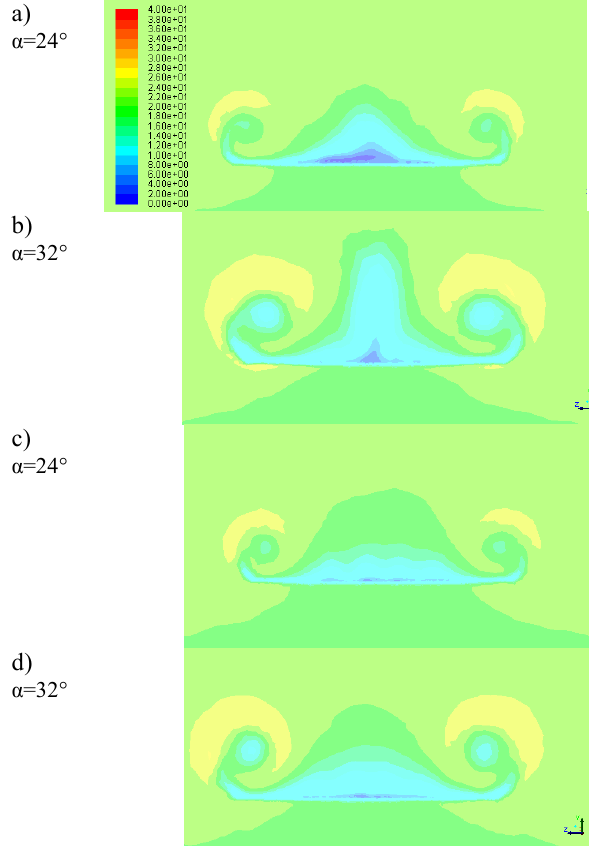
Fig. 6. The velocity contours at cross plane of the wings at α =24 ° and α =32 ° with Transition SST model for rigid wing (a- b) and for tubercle wing (c-d)